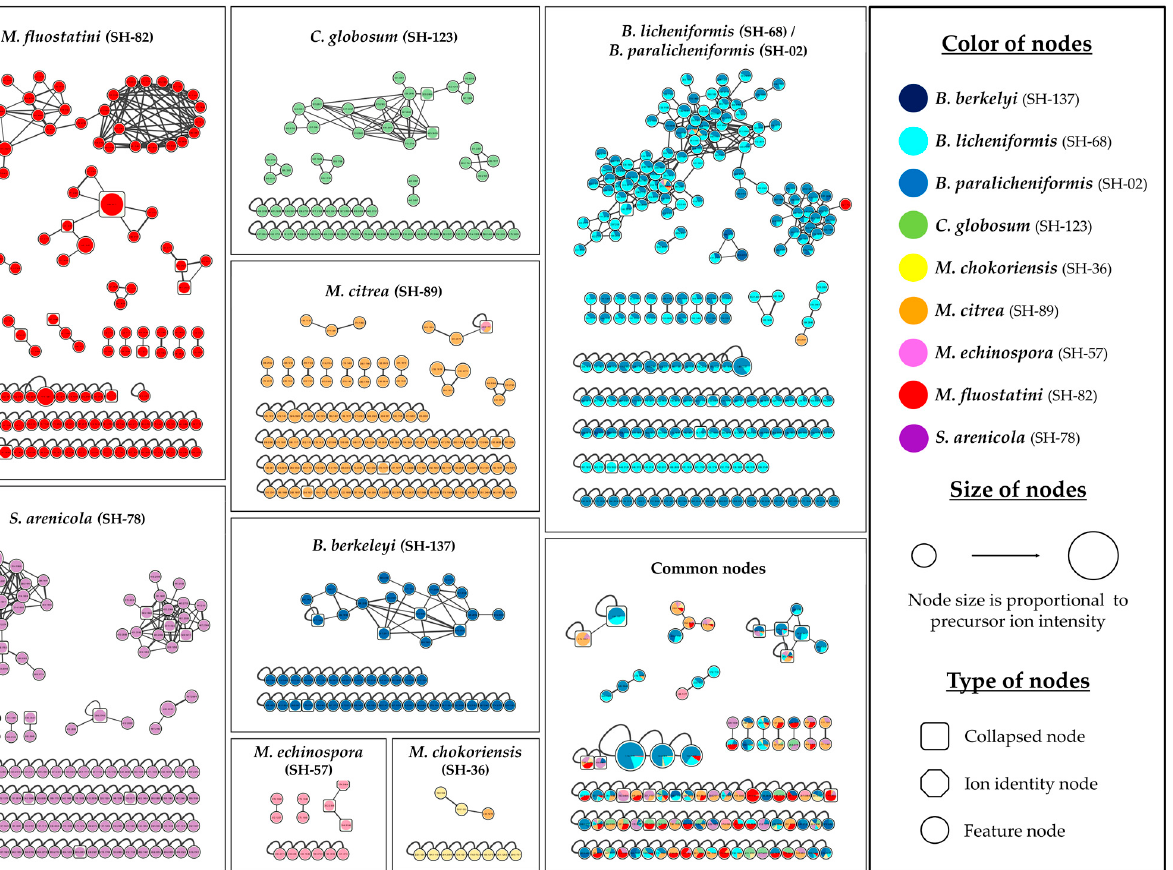
Figure 1. Ion Identity Molecular Network (IIMN) of the 9 microbial extracts. Node’s color describes the bacterial species, node’s shape is related to the adduct type and the collapsed property and node’s size is proportional to precursor ion intensity (The figure is in high definition, with the possibility of zooming-in).